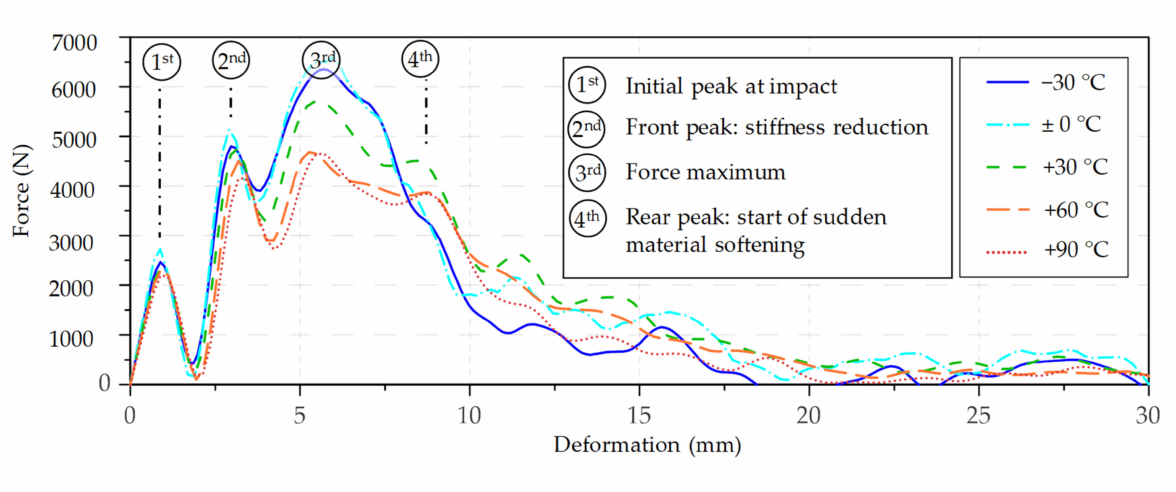
Figure 8. Force–deformation diagram of the mean value curves of beech wood by temperature